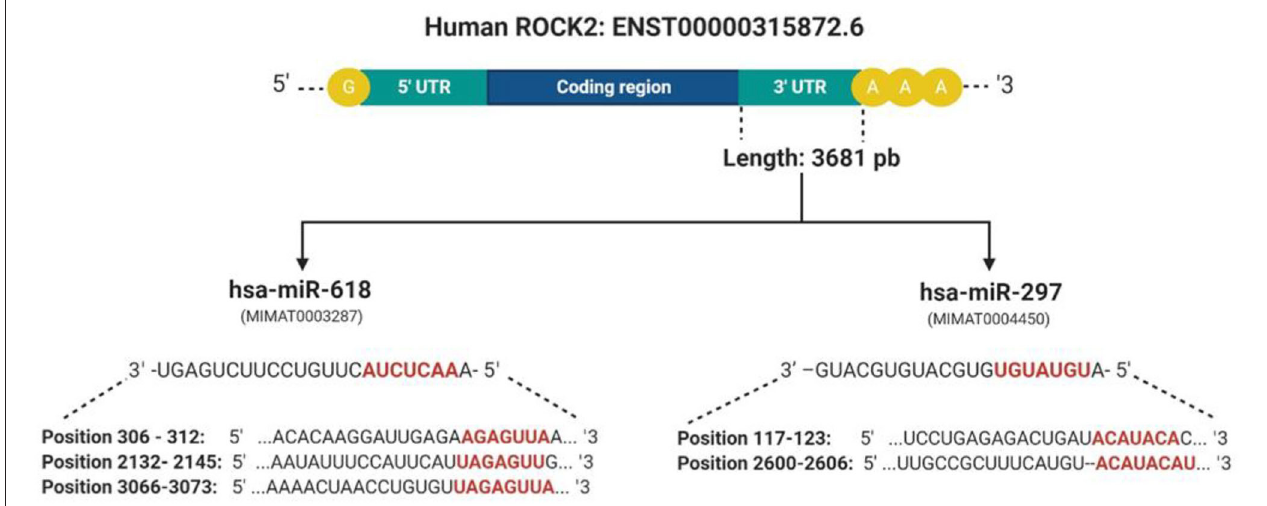
FIGURE 3 | Presentation of complementary sites and base pairs of the miRNAs hsa-miR-618 and hsa-miR-279 with the 3 ′ UTR sequence of the ROCK2 kinase. These were predicted by software: TargetScan, miRDB, and mirDIP 4.1. Created with